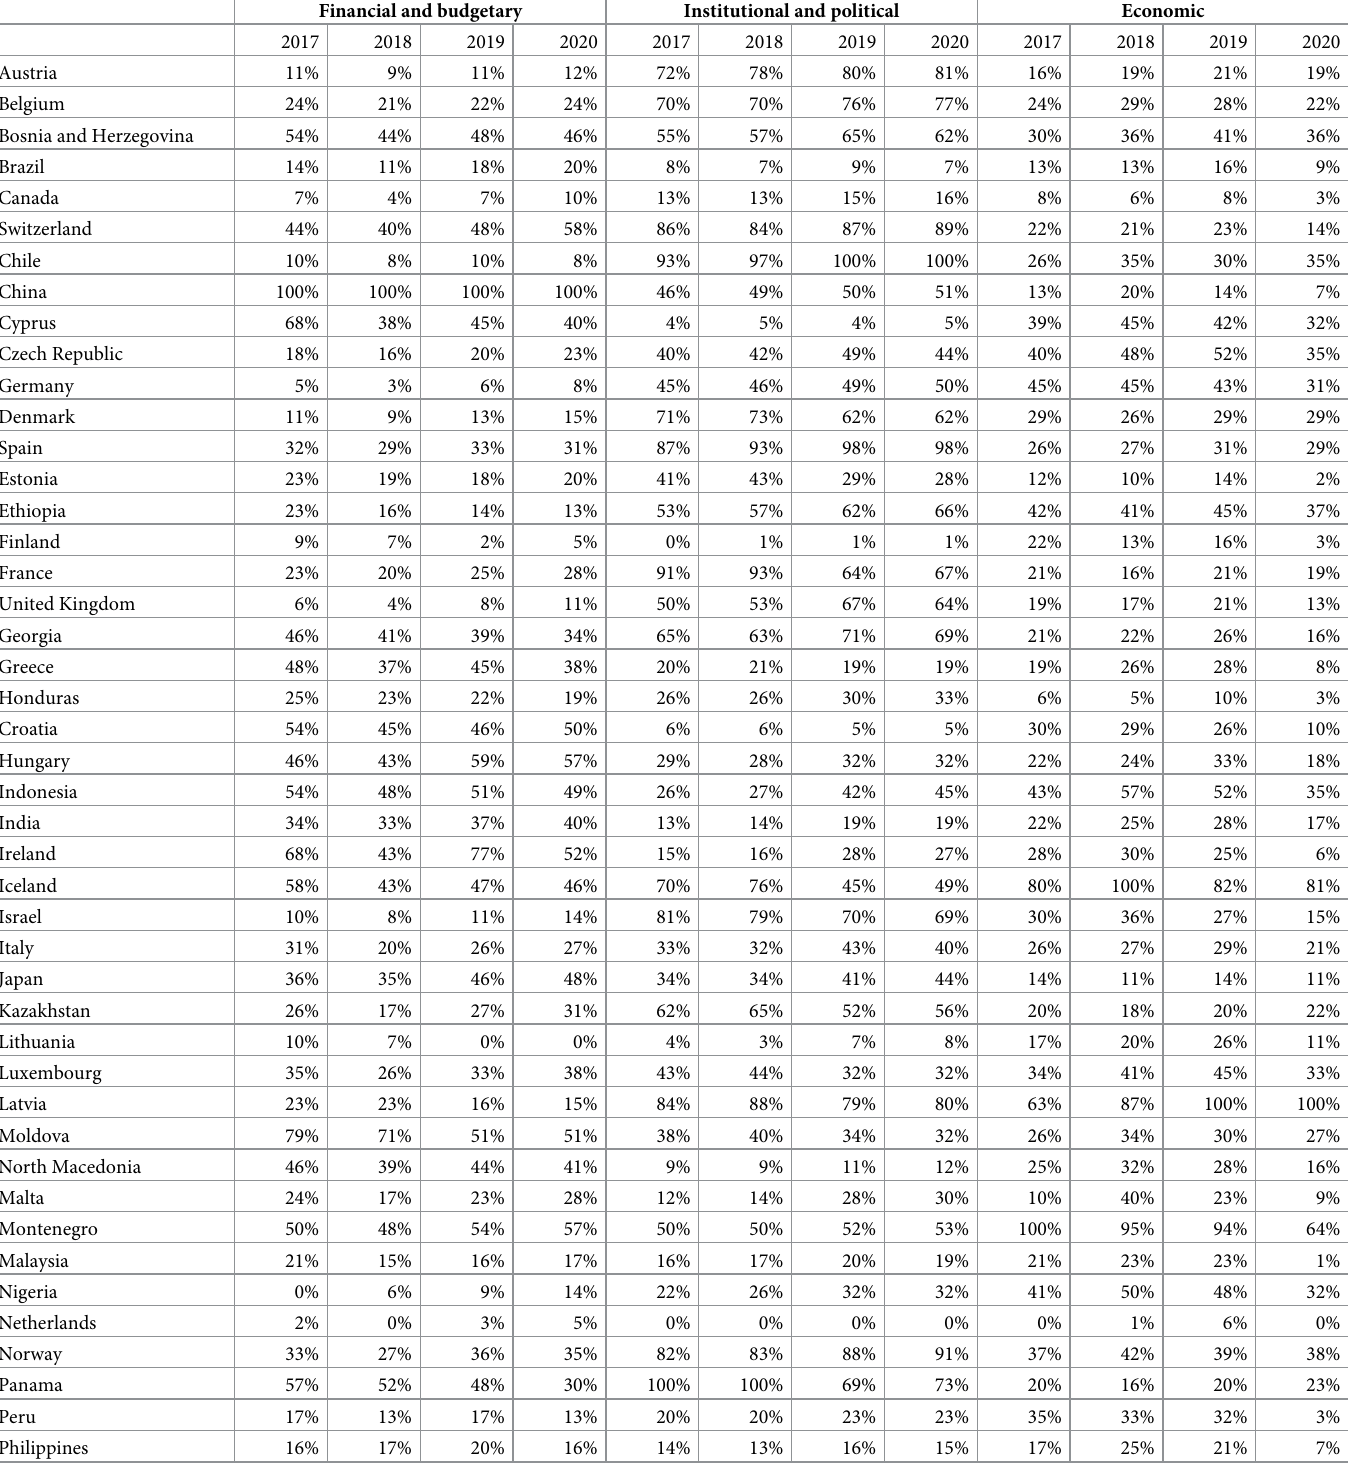
Table 7. Normalized results of integral indices for assessing the economic, political-institutional and financial-budgetary development of the countries of the